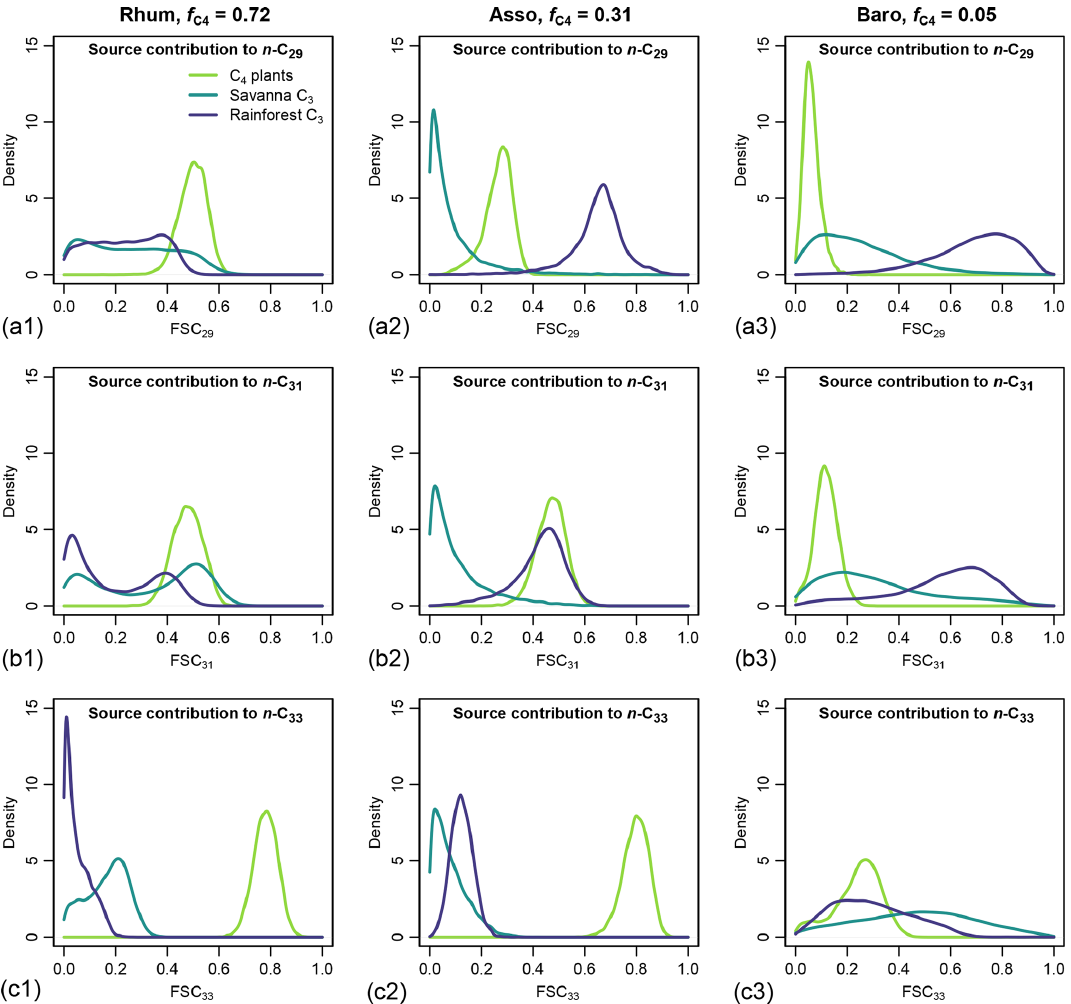
Figure 10. Posterior densities of fractional source contribution (FSC n ) of terrestrial plants, aquatic macrophytes, and algae to each specific alkane chain ( n -C 29 , n -C 31 and n -C 33 ) in published lake surface sediment samples from